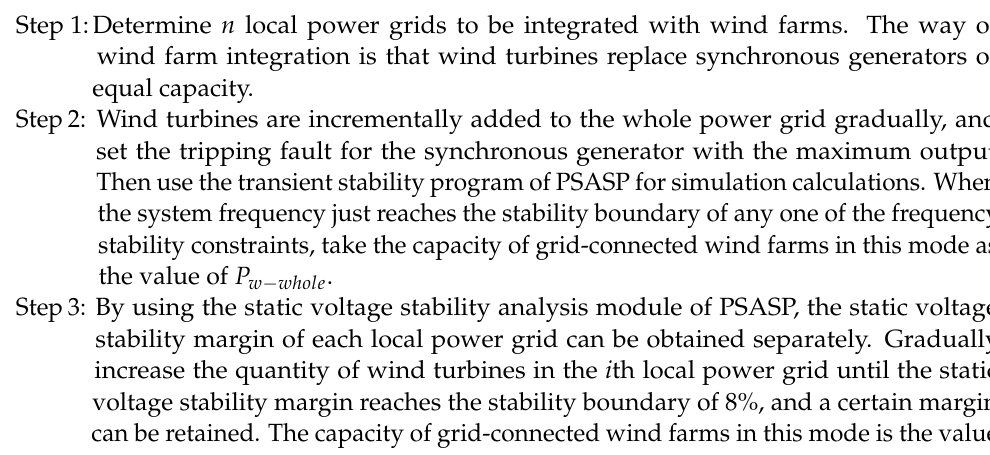
Figure 4. Flowchart of the proposed method for assessing the maximum capacity of grid-connected wind farms under the joint constraints of frequency and voltage